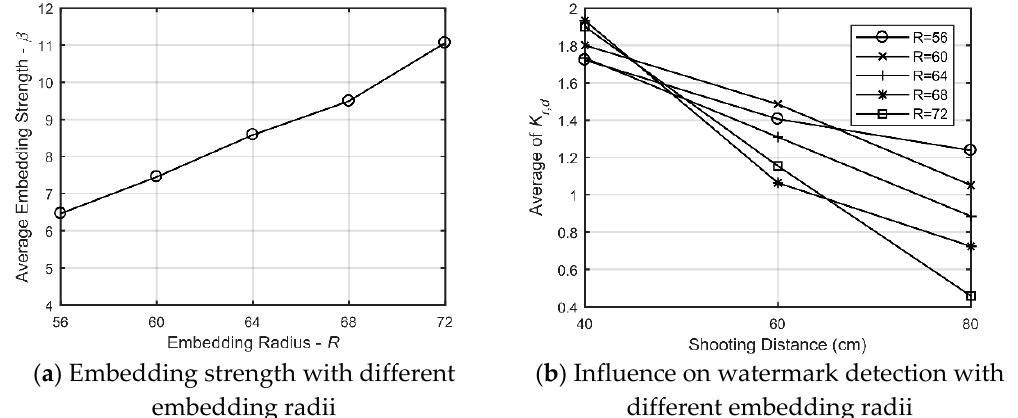
Figure 11. Influence of different embedding radii.